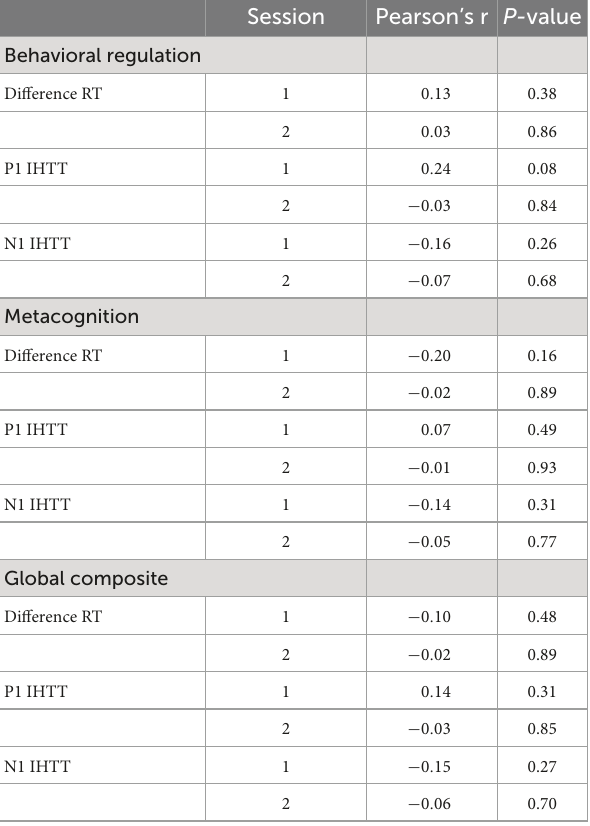
TABLE 5 Behavior Rating Inventory of Executive Function Parent Questionnaire (BRIEF) subscales and P1 and N1 interhemispheric transfer time (IHTT) correlations.